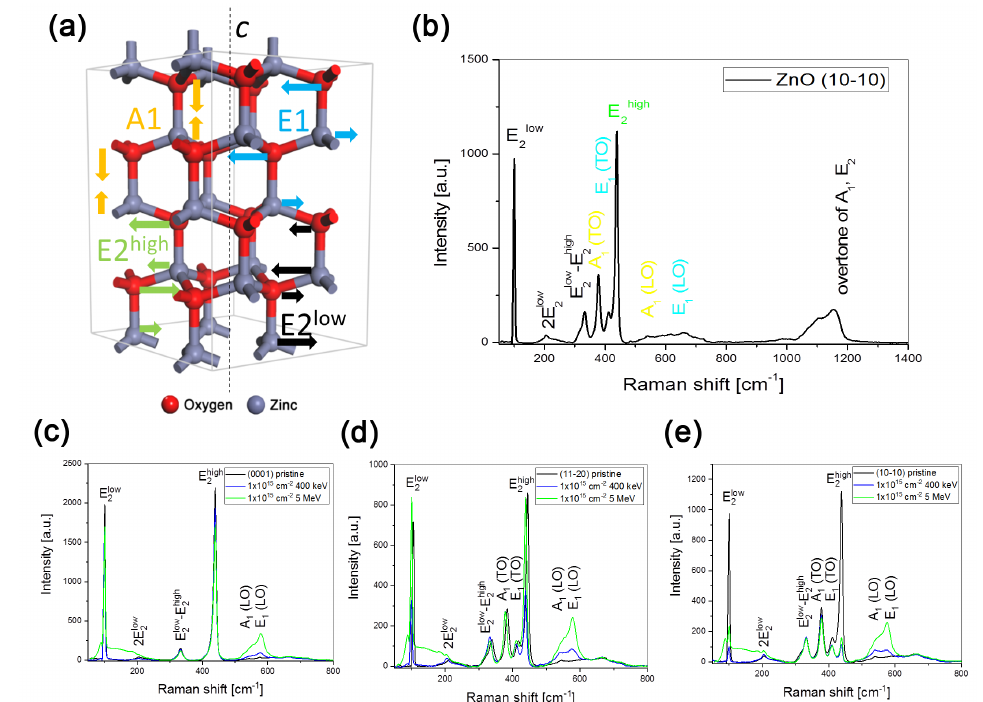
Figure 6. The Raman spectra of the Au:ZnO structure measured for the lower and higher applied energy of ion implantation in various cuts: ( a ) the representation of atomic displacement corresponding to active optical modes in the wurtzite ZnO structure; ( b ) all Raman vibration bands characteristic of ZnO shown in the spectrum of m -plane ZnO. Both figures were made according to [47]. Figures ( c – e ) are comparisons of the Raman spectra collected for the implantation energy of 0.4 MeV and 5.0 MeV in various ZnO cuts used. This figure includes samples implanted with the fluence of 1 × 10 15 ions / cm 2 , with post-implantation annealing at 600 ◦ C in an O 2 atmosphere for 1